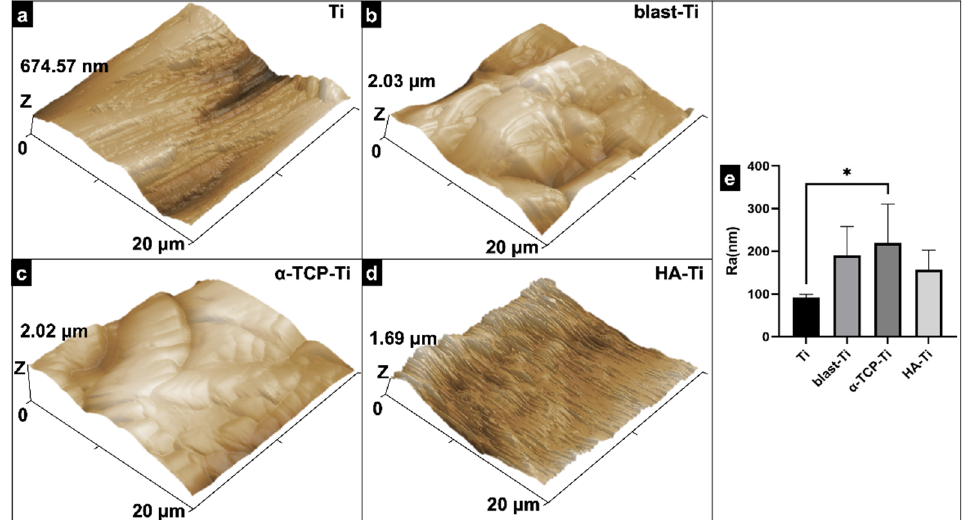
Figure 4. Scanning probe micrographs of ( a ) Ti, ( b ) blast-Ti, ( c ) α -TCP-Ti, and ( d ) HA-Ti discs. ( e ) Roughness (Ra) values of Ti, blast-Ti, α -TCP-Ti, and HA-Ti discs. The data shown are means ± SD ( n = 3); * p < 0.05.